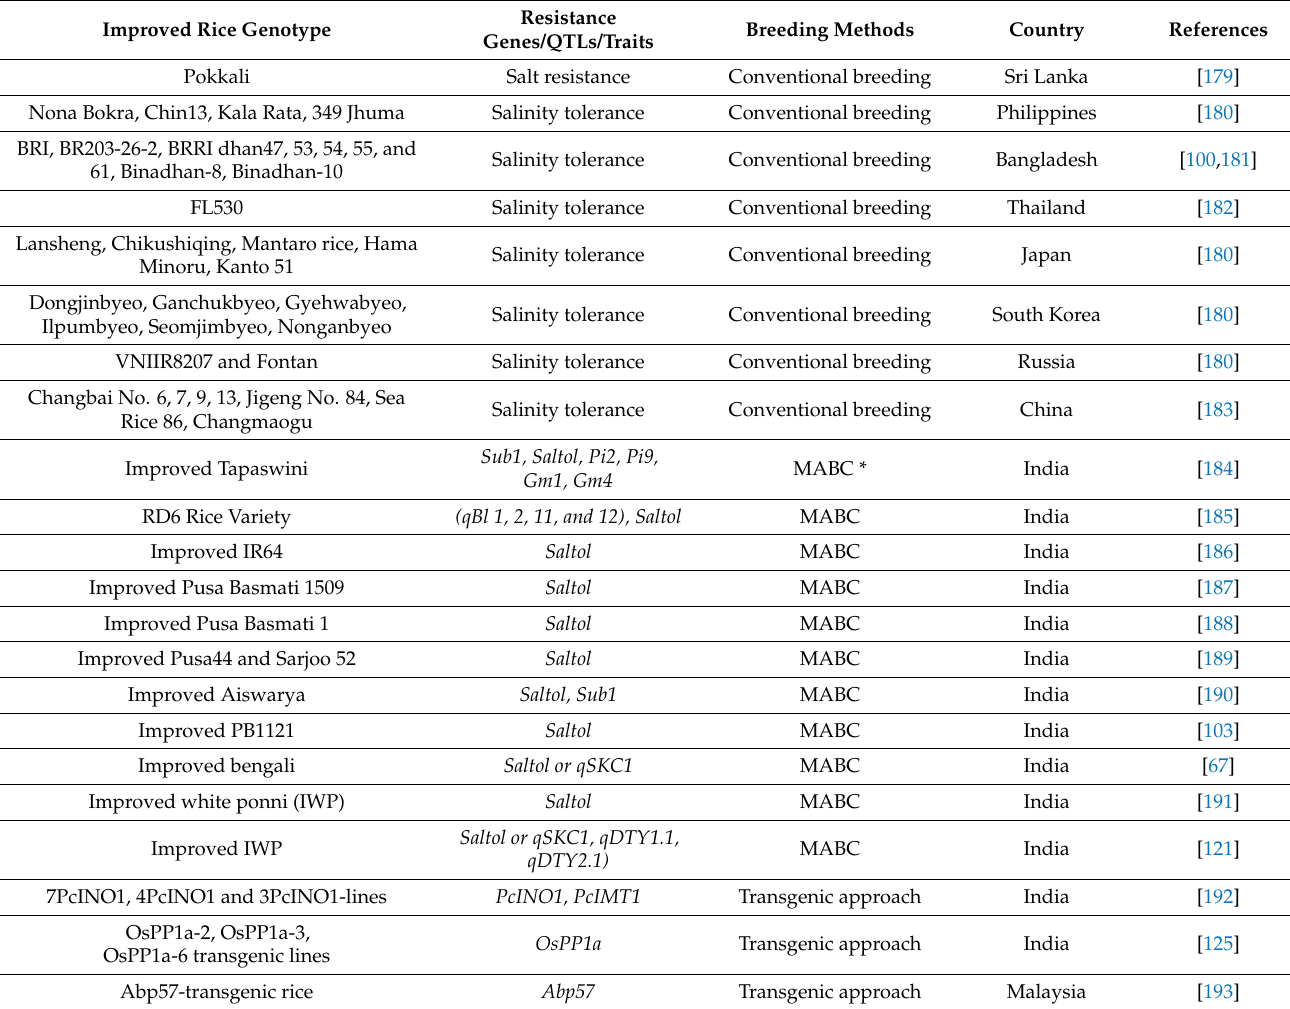
Table 3. Recently developed salt-tolerant rice varieties through application of different breeding methods in different countries. Resistance Breeding Methods Improved Rice Genotype Genes/QTLs/Traits